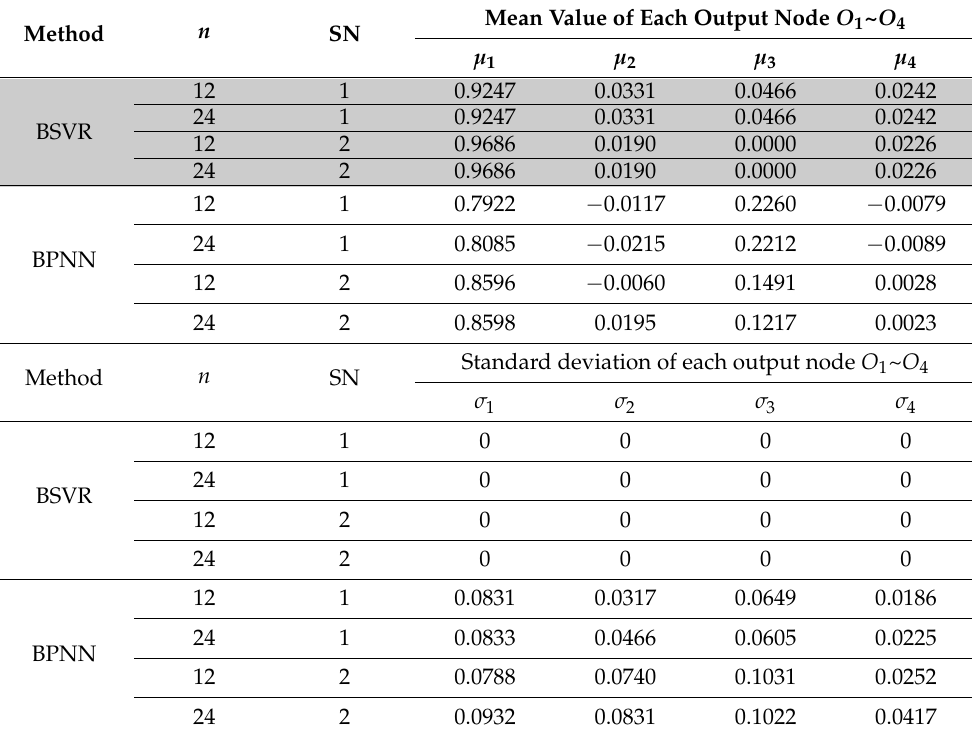
Table 7. The Consistency Test of the Two Methods (mean value and standard deviation).